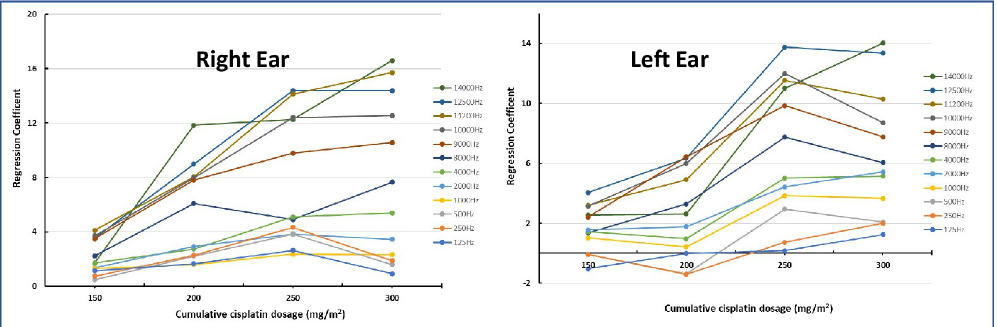
Fig 5. Influence of cumulative cisplatin dosage on hearing thresholds in the right and left ear, after adjustment for age and HIV status. Dose Effect is evident bilaterally. Clustering of extended high frequencies together and the conventional frequencies together is visible bilaterally. Plateau effect is visible at 250mg/m2 from 8000 to 14000Hz in the left